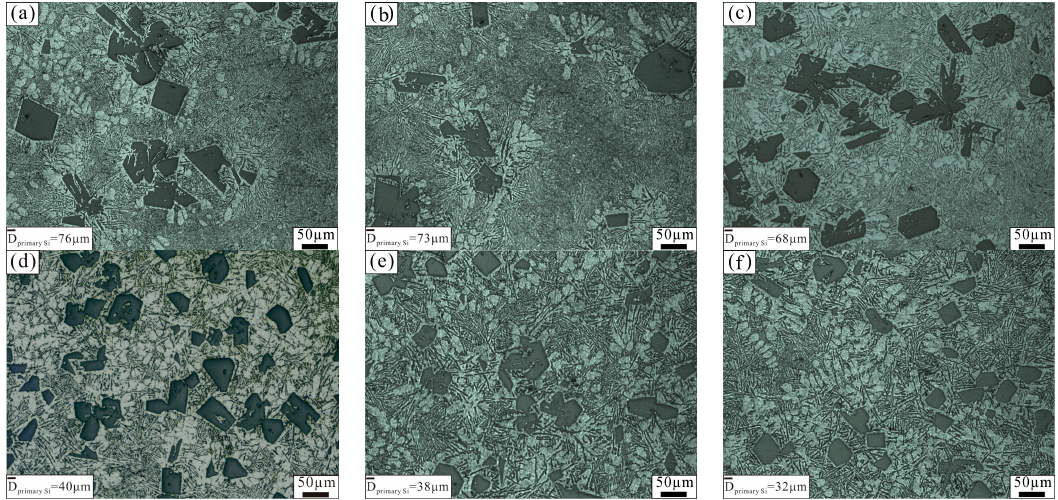
Figure 5. Microstructure of the unmodified Al–18Si alloy and the alloy modified at different temperatures: ( a ) 750 °C, unmodified; ( b ) 800 °C, unmodified; ( c ) 850 °C, unmodified; ( d ) 750 °C, ( a ) 750 ◦ C, unmodified; ( b ) 800 ◦ C, unmodified; ( c ) 850 ◦ C, unmodified; ( d ) 750 ◦ C, modified; ( e ) 800 ◦ C, modified; ( e ) 800 °C, modified; ( f ) 850 °C, modified. modified; ( f ) 850 ◦ C,